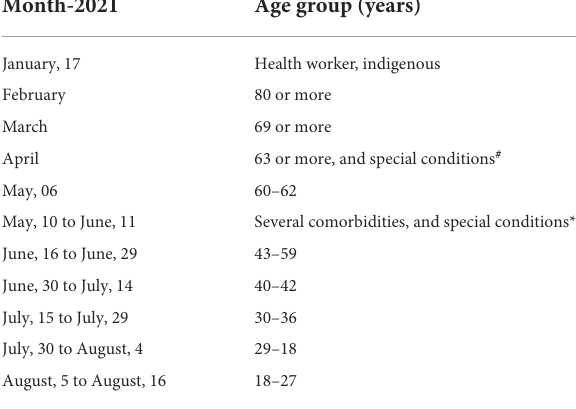
TABLE 1 COVID-19 vaccination schedule for adults